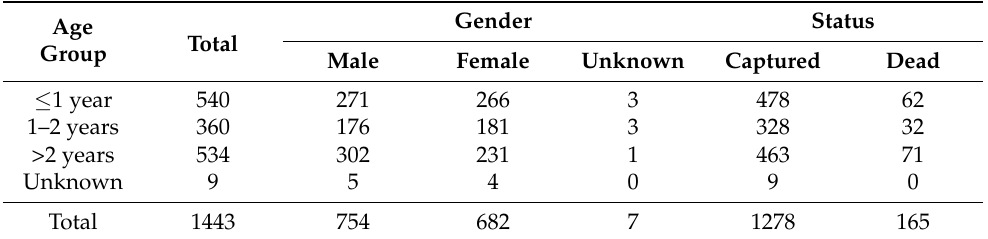
Table 1. Summary of wild boar samples collected in Gifu prefecture between September 2018 and August